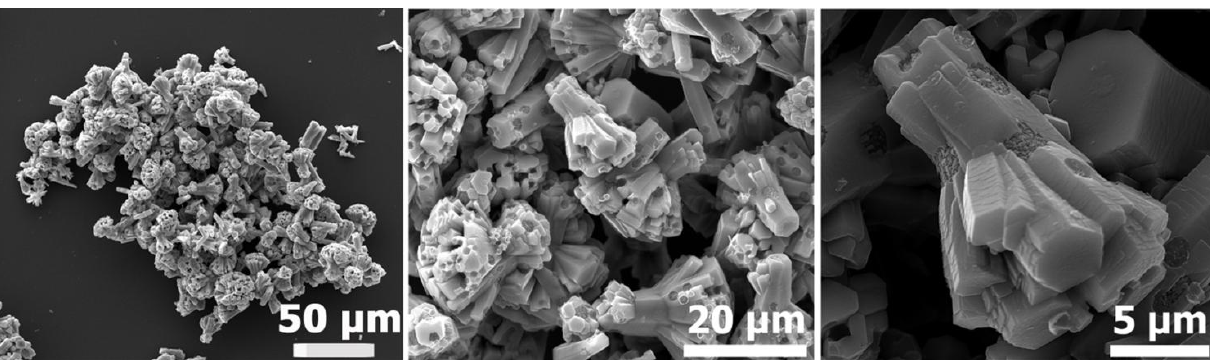
Figure 1. “Cauliflower-like” ZnO microparticles: Scanning electron microscope (SEM) images of different